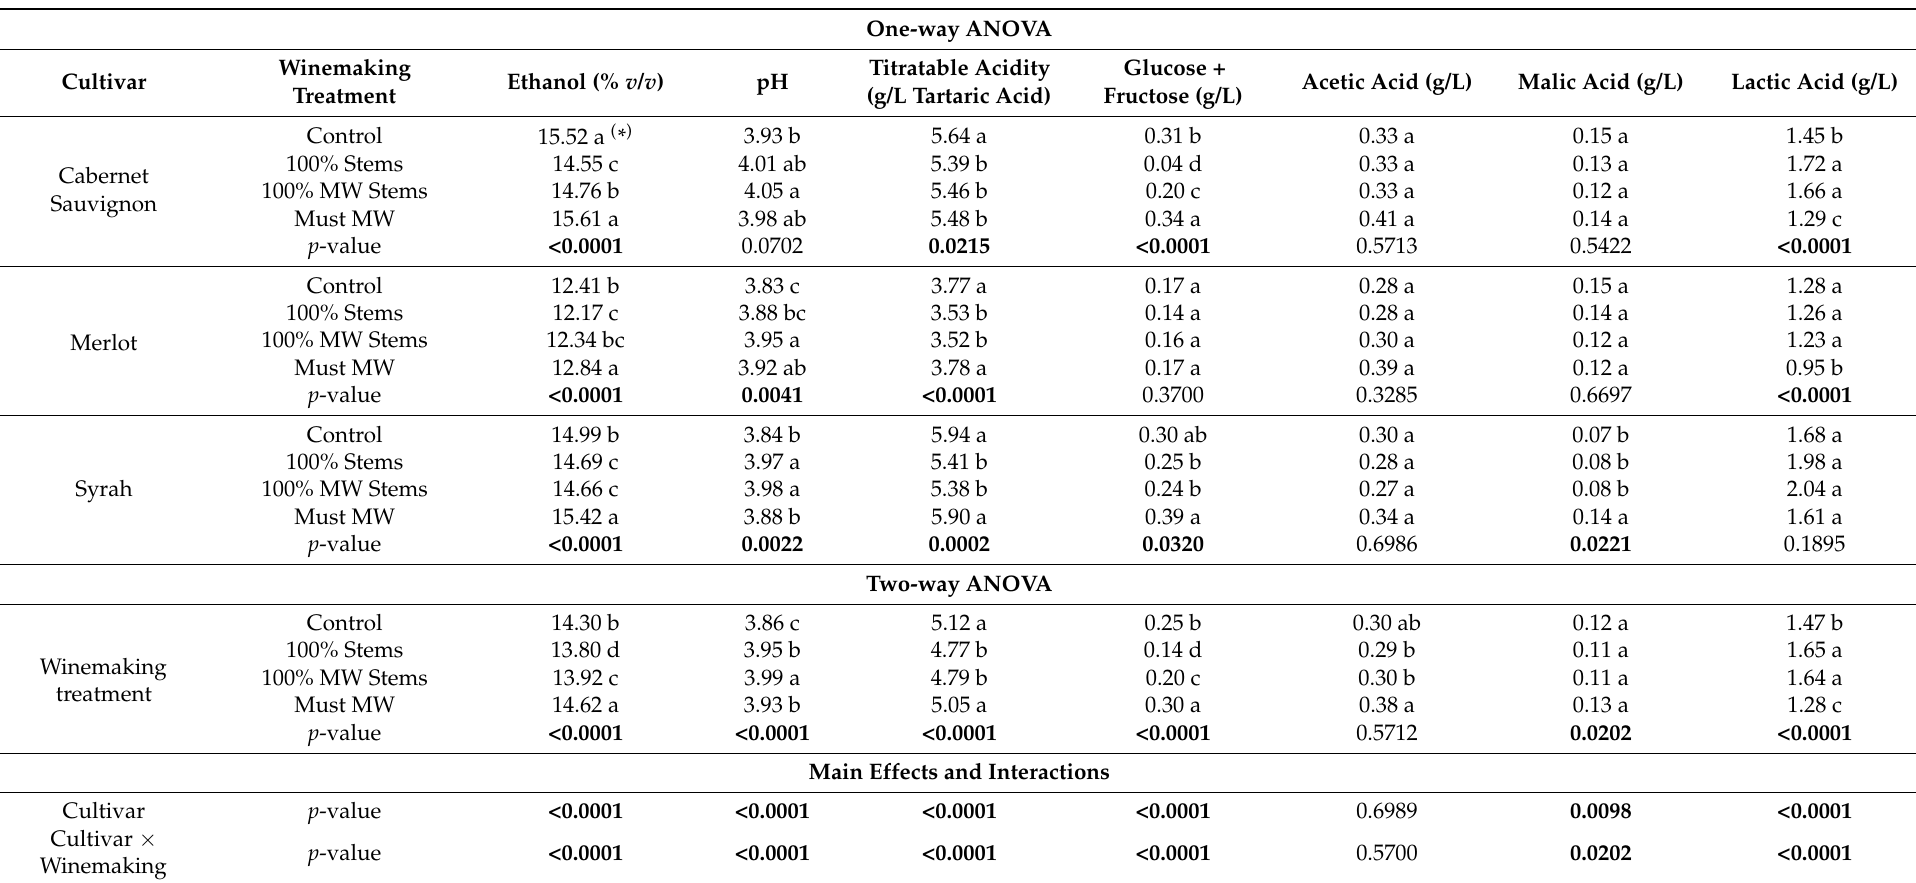
Table 2. One-way and two-way analyses of variance (ANOVA) separating the effects of cultivar and winemaking treatment on the basic chemical composition of Cabernet Sauvignon, Merlot and Syrah wines from the 2016 vintage. Values represent the mean of three tank replicates ( n =